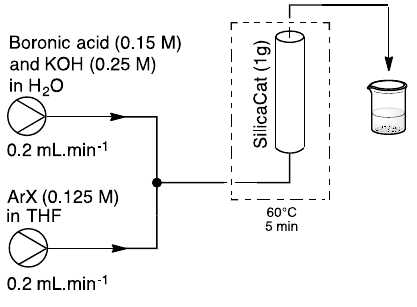
Figure 6. Substrate scope of continuous flow Suzuki–Miyaura cross-coupling sequence using Pd dendrimers encapsulated